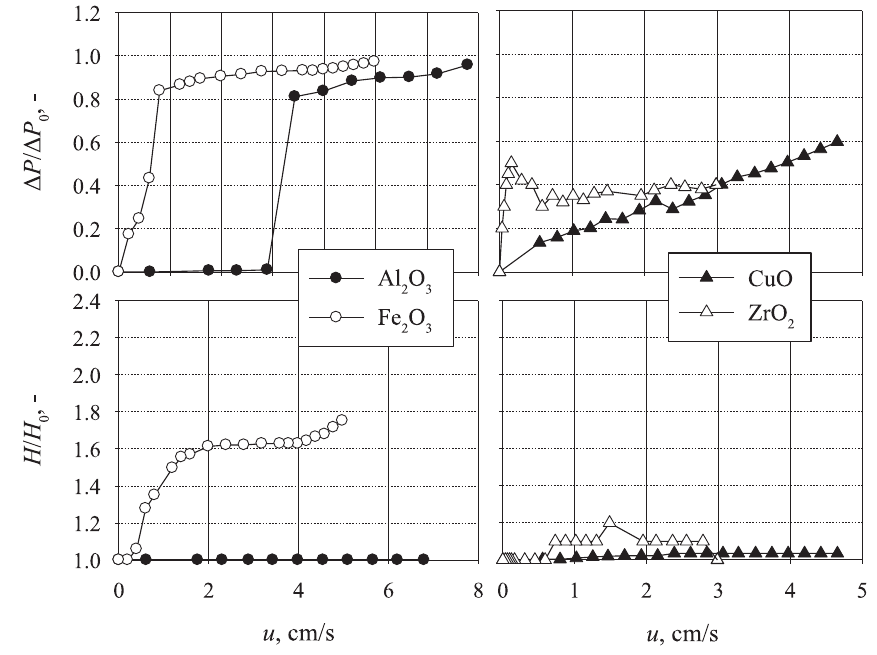
Fig. 1 Dimensionless pressure drop (Δ P /Δ P 0 ) and bed expansion ( H / H 0 ) obtained under ordinary